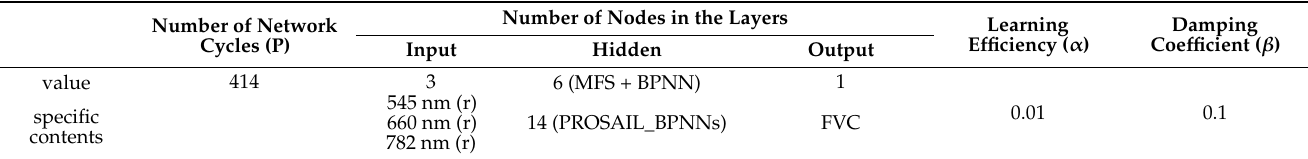
Table 2. The input parameters of the BPNNs in the